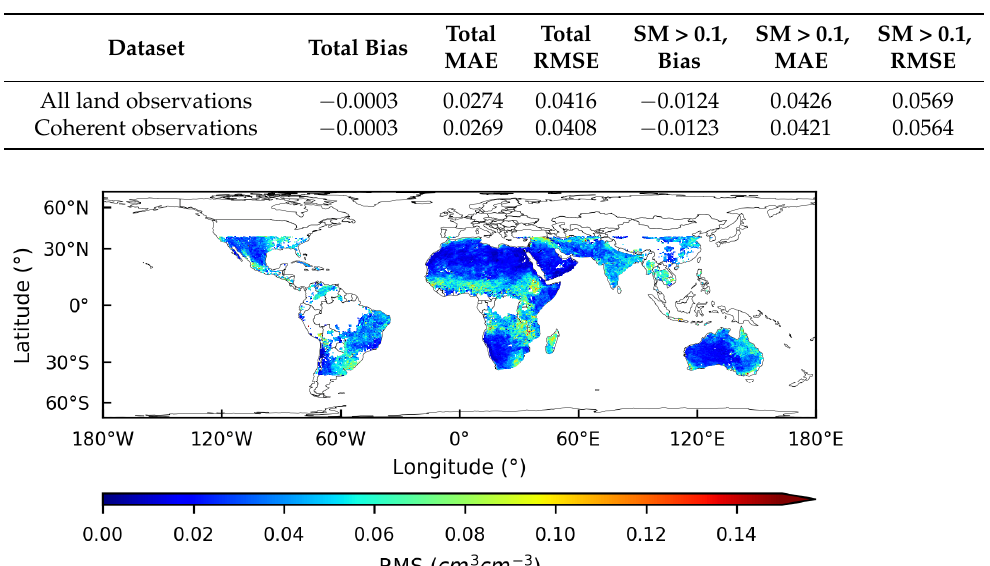
Table 2. Soil moisture retrieval model evaluating with k-fold cross-validation (unit: cm 3 /cm 3 ).